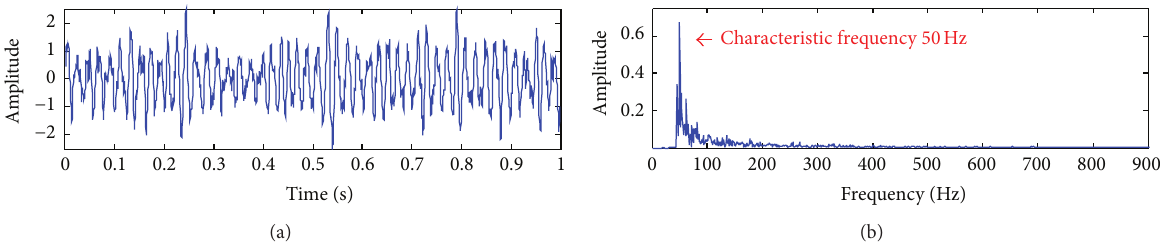
Figure 6: Result of the ASR method for the simulation signal: (a) output signal and (b) frequency spectrum of the output signal.